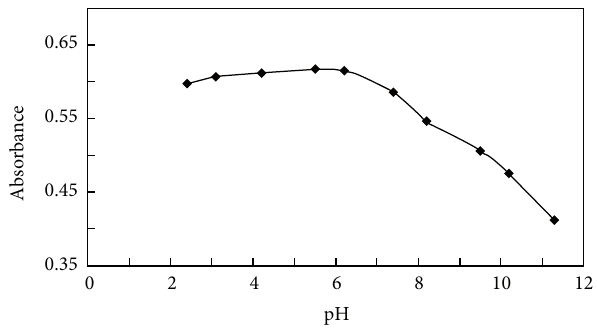
F 1: Effect of pH on the extraction efficiency. Experimental conditions: volume of buffer; 9mL, amount of PEG 4000; 4gm, amount of sodium carbonate; 2.5gm, temperature; 35 ing time; 10min, 4ng/mL of brilliant blue.